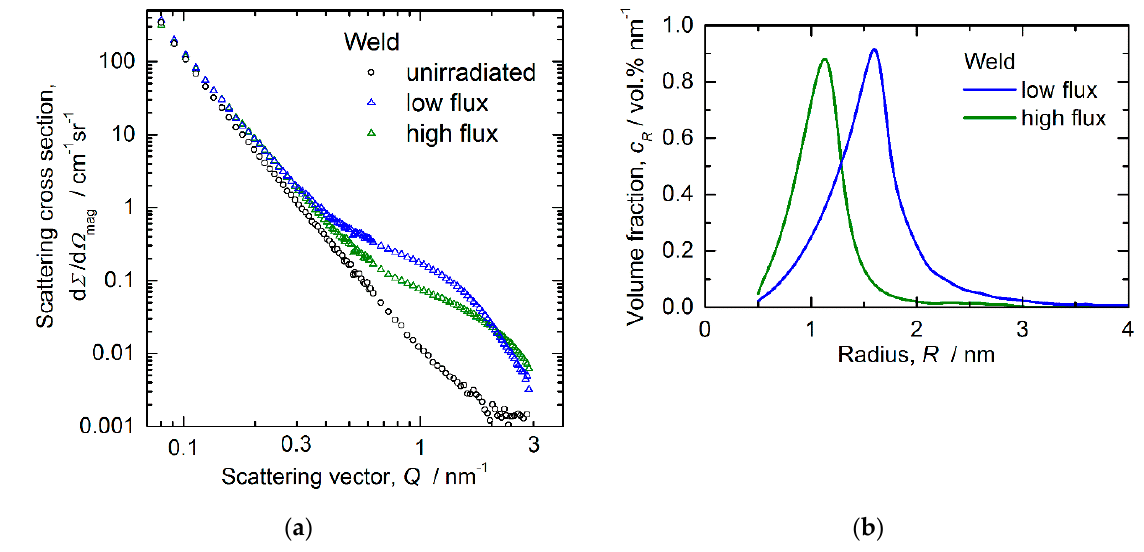
Figure 8. Results from magnetic SANS for the RPV weld, ( a ) magnetic scattering cross sections, ( b ) reconstructed size distributions of irradiation-induced scatterers.